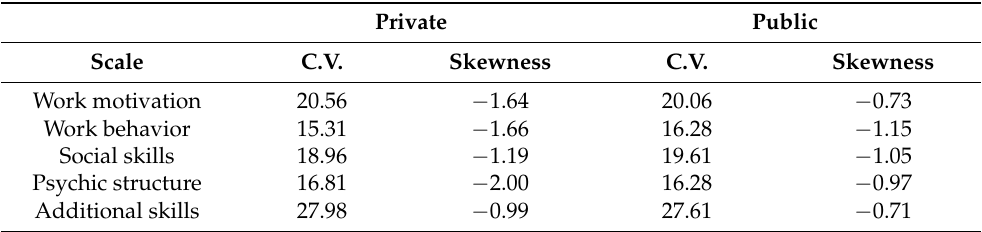
Table 20. Coefficients of variation (C.V., measured in percent) and skewness of the overall answers of the different scales of the questionnaire when the sample is differentiated by the tenure of the